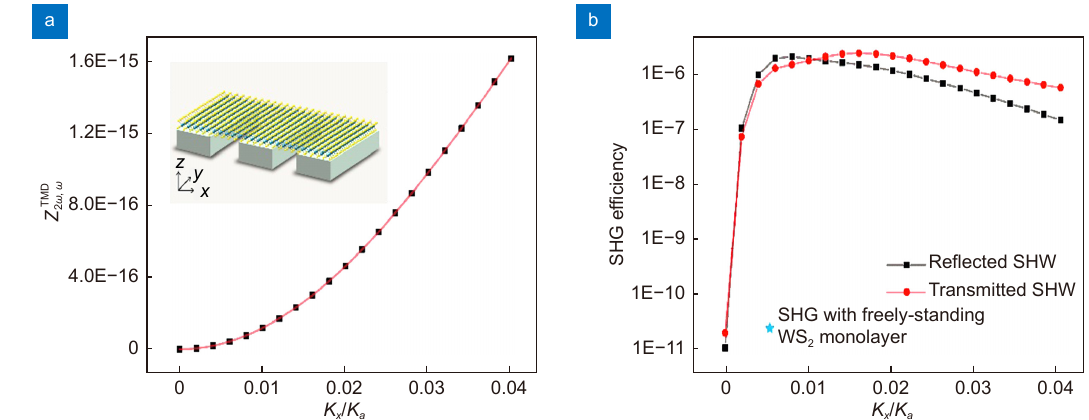
Fig. 2 | Spatial overlap coefficient and SHG efficiency with a homogeneous WS 2 on top of the photonic grating slab. ( a ) The K x depend- ent spatial overlap coefficient . ( b ) The K x dependent SHG efficiency monitored at the reflected (top) and transmitted (bottom) side, respect- ively. The blue star is a reference point for showing the SHG efficiency with a freely-standing WS 2 monolayer. The FW is incident from the top side of the grating, and the intensity of FW is set to be 0.1 GW/cm 2